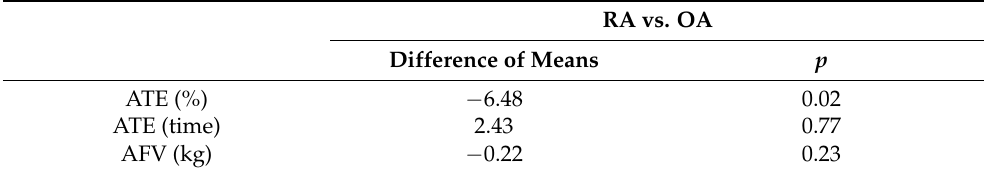
Table 3. Comparison of proprioception functional examination results in a circular movement between